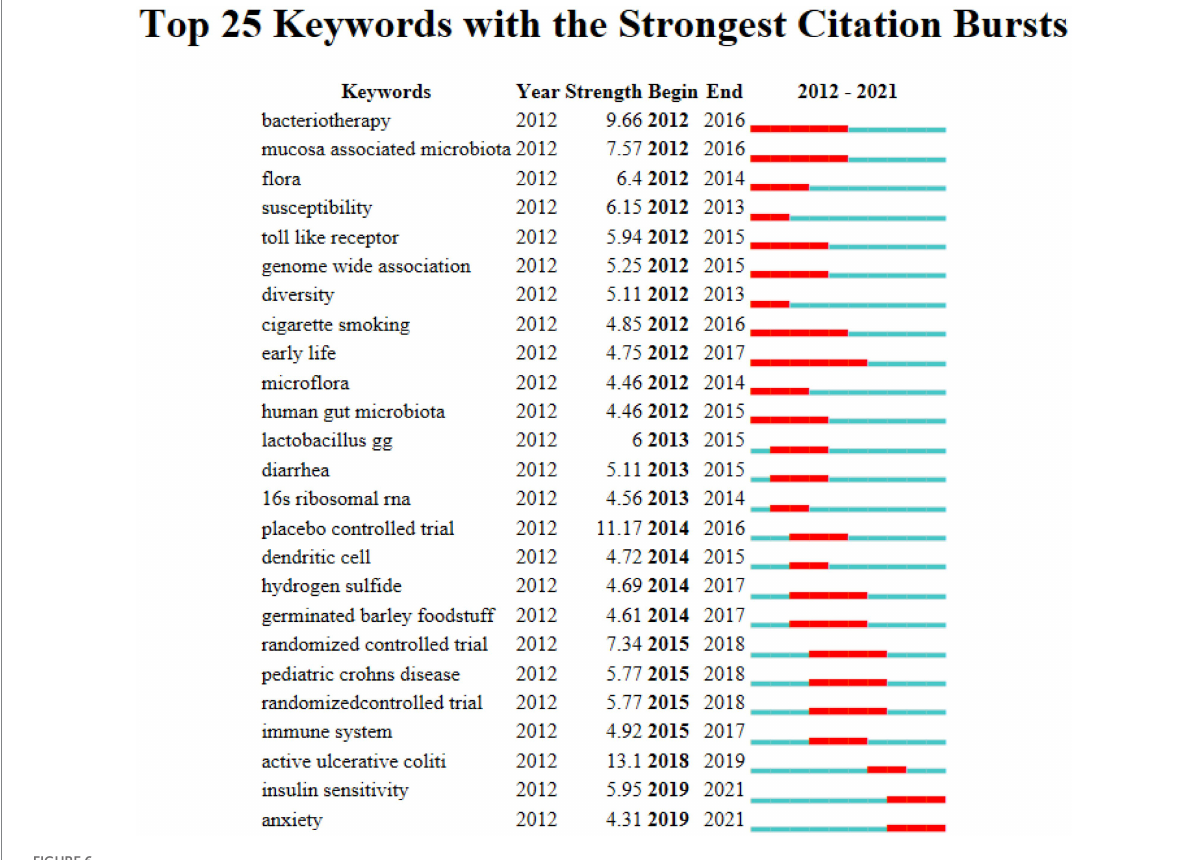
FIGURE 6 Keyword burst